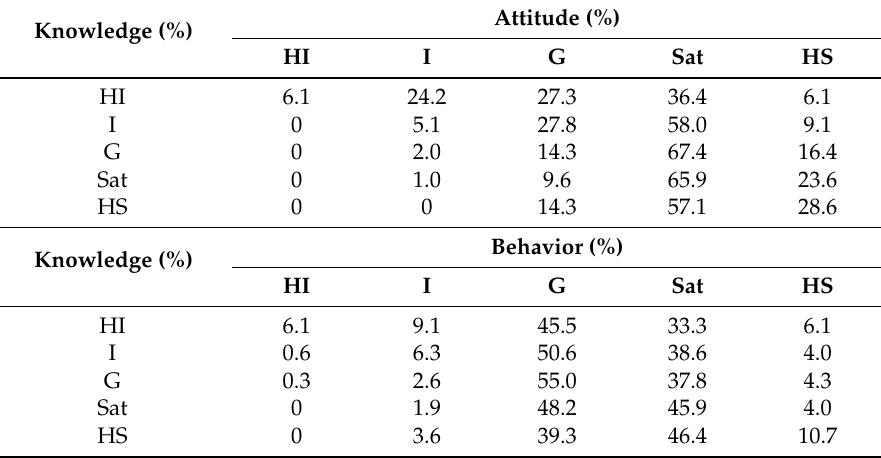
Table 2. Percentage distribution of eating out related KAB ( n = 1634).